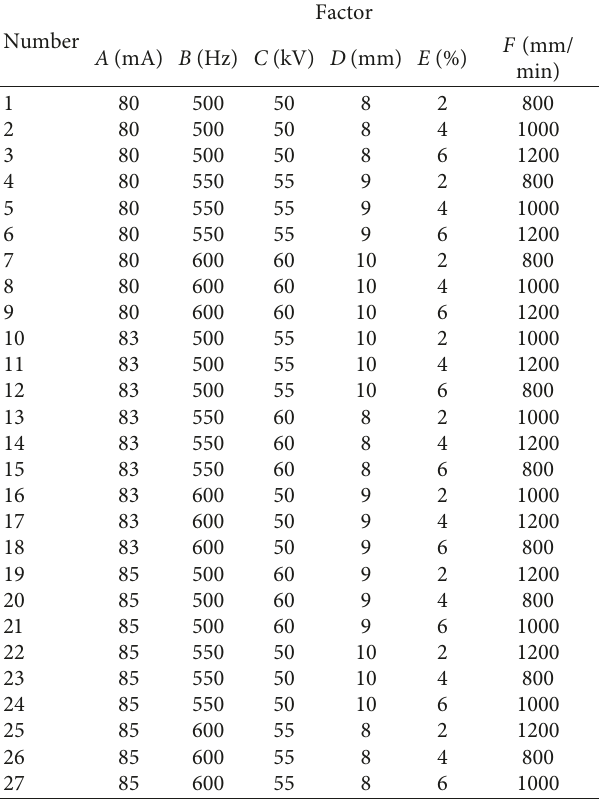
Table 3: Cladding orthogonal experiment of